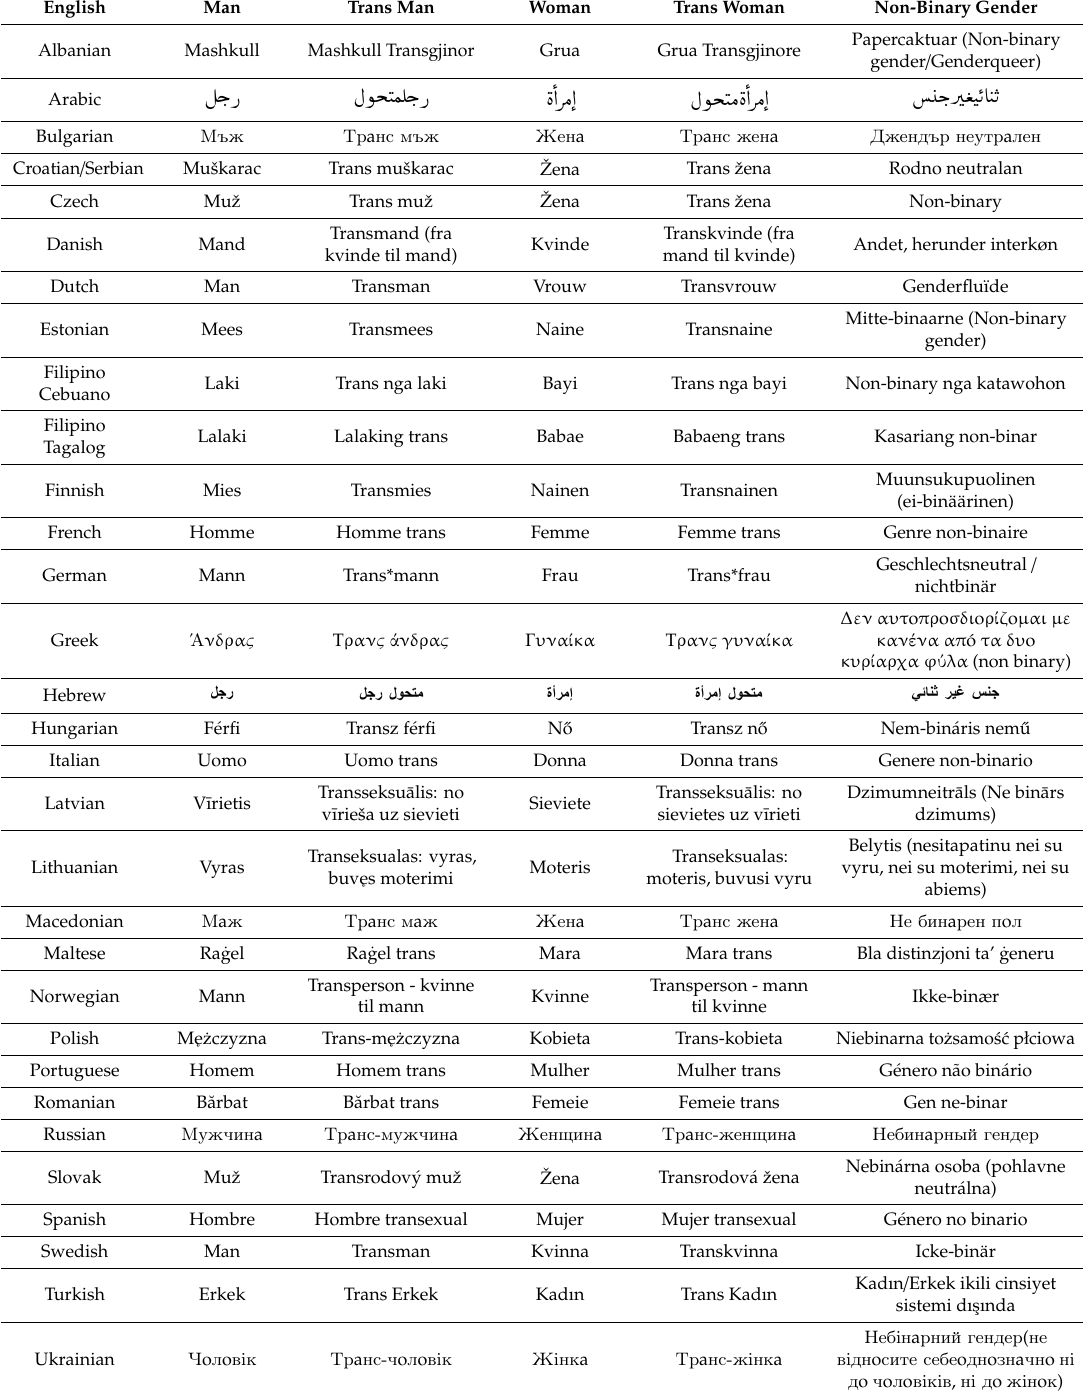
Table A1. Gender identity terms used in the European MSM Internet Survey (EMIS) 2017 response sets.